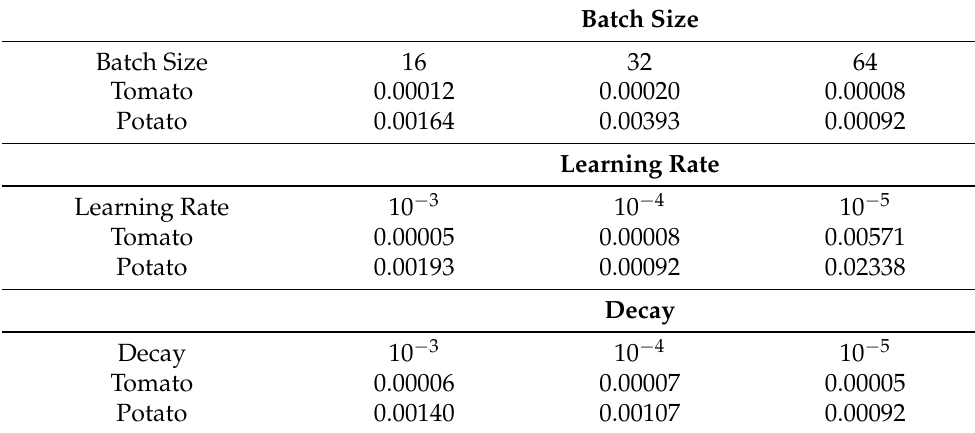
Table 7. Validation lost under different